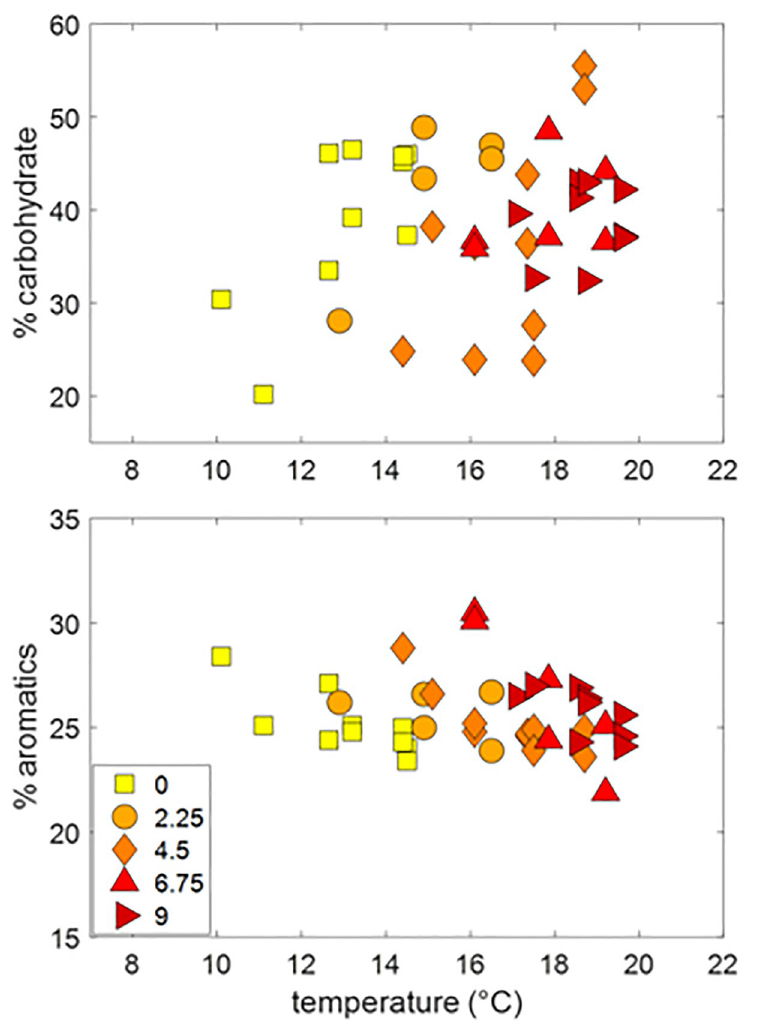
Fig 4. Regressions versus temperature. Temperature regressions of percent carbohydrate (panel A) and percent aromatics (Panel B) in the surface peat ( � 50 cm) collected in 2019. Data are plotted against the actual averaged measured temperature at each peat depth averaged for the month of August 2019. Symbol colors indicate the temperature treatment differential. Regression analyses were not significant for either % carbohydrate or % aromatics (p >